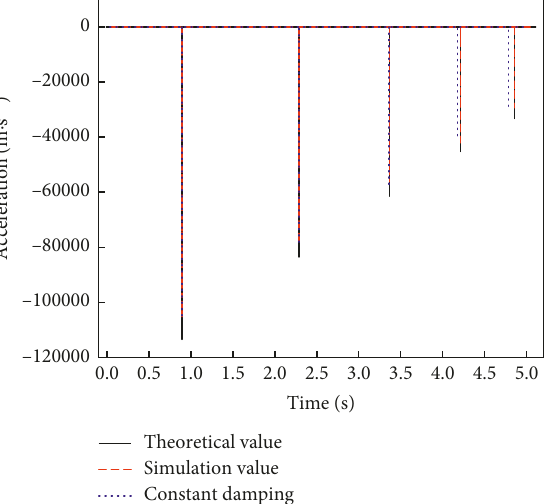
Figure 6: Contact force.